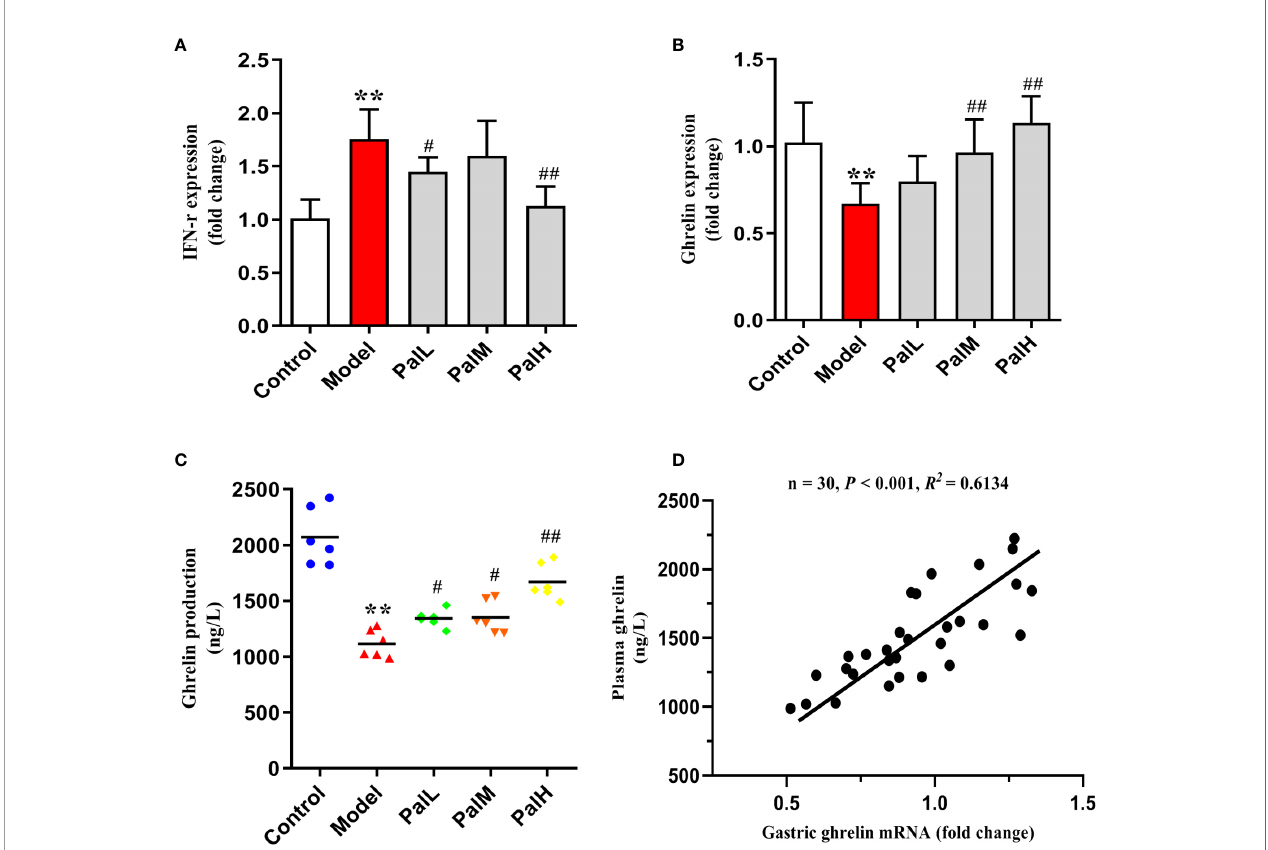
FIGURE 4 | Pal relieved the release disorder of ghrelin by inhibiting IFN- g . (A, B) IFN- g and ghrelin mRNA in gastric mucosa were analyzed by RT-PCR (n=6). (C) ghrelin production in serum was measured by ELISA (n=6). (D) Pearson correlation coef fi cient analysis of ghrelin expression in gastric mucosa and serum. ** P < 0.01 vs control group. # P < 0.05 and ## P < 0.01 vs model group. PalL (10 mg/kg); PalM: (20 mg/kg); PalH: (40